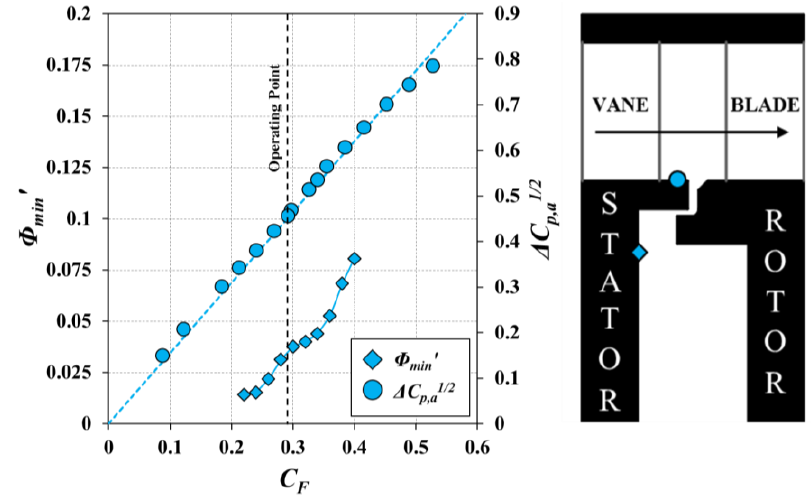
Figure 12. Effect of flow coefficient C F on Φ min ’ and Δ C p,a 1/2 for the single radial-clearance seal in the upstream wheel-space at r / b = 0.958 and annulus at location A2 ( Re ϕ = 7.2 × 10 5 ) (blue, dashed line denotes correlation based on Equation (4) and k a = 1.55).